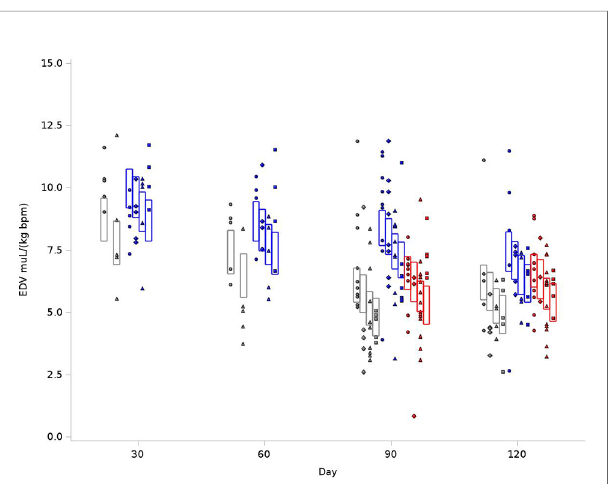
FIGURE 2 | Graphical representation of values for End Diastolic Volumes (EDV) in rats at 4 time points (X-axis). The rats were measured at 4 time points: 30, 60, 90 and 120 days. The values observed are represented by symbols denoting the experimental treatment: Circle (No Radiation and No Lisinopril -R-L), Diamond (No Radiation and Lisinopril -R+L), Triangle (Radiation and No Lisinopril +R-L), or Square (Radiation and Lisinopril +R +L). The colors represent the strain: Brown-Norway (BN: black), Salt-Sensitive (SS: blue) and SS with BN chromosome 6 (SSBN6: red). The rectangles are 95% Con fi dence Intervals for EDV from a Repeated Measures linear model for treatment that included time, strain, and the SS by day 90 interaction. EDV were normalized to body weight and heart rate and was reduced by 9-11% in all irradiated rats at 120 days (p=0.0013) as compared to their non-irradiated